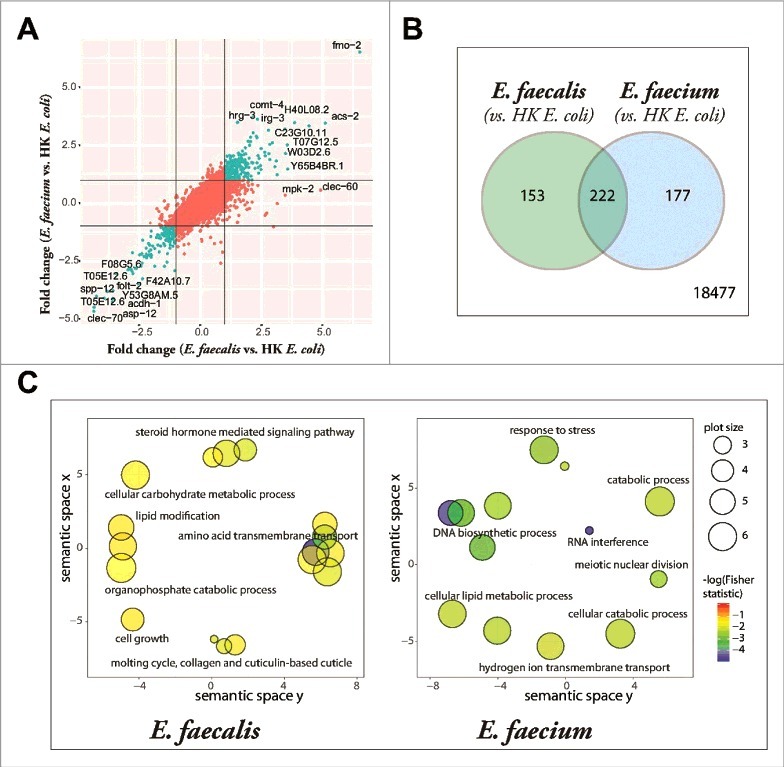
Enterococcus infection gene signature. (A) Fold-change by fold-change plot, depicting E. faecalis-infected C. elegans with E. faecium-infected C. elegans (relative to heat-killed E. coli-fed controls). Genes differentially expressed by both E. faecalis and E. faecium (relative to HK E. coli, |FC| > 2) are highlighted in aquamarine. 18,477 annotated Affymetrix probes were found to not be differentially expressed in either comparison. (B) The set of differentially expressed genes (|FC| > 2, BH-adjusted p-value < 0.05) in the E. faecalis infection signature (375) shared a significant overlap with genes differentially expressed in the E. faecium infection (399), p = 1.37 × 10295. (C) Functional classification summary of the differentially expressed genes that are exclusive to either E. faecalis (left) or E. faecium (right), relative to heat-killed E. coli. Similar functional categories of GO terms were clustered together in two-dimensional space using REViGO, a visualization tool that uses a clustering algorithm to represent GO data by plotting their semantic similarity. The bubble color indicates the Fisher test statistic while the bubble size is proportional to the frequency of GO terms in the GO annotation database. Colors corresponding to log10 Fisher test statistic are provided in the legend.)